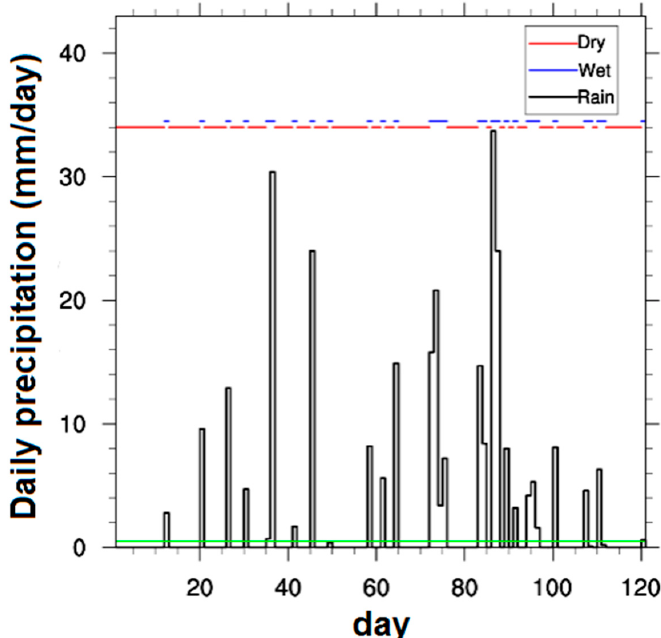
Figure 1. Distribution of rainy and dry episodes during the monsoon in 2001 in Sahel, using GPCP (Global Precipitation Climatology Project) daily rainfall data. The wet and dry events are marked by blue and red line respectively, and the threshold equal to 0.1 mm is marked by a green line. The day 0 and 120 correspond to the 15 August 2001 and 12 October 2001 respectively.